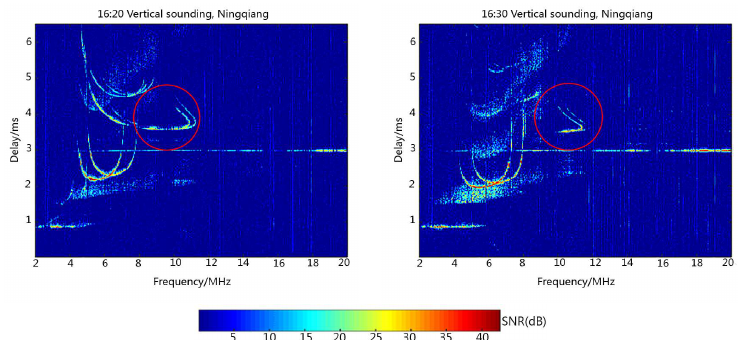
Figure 5. Multi-station sounding experiment using the same complementary code.